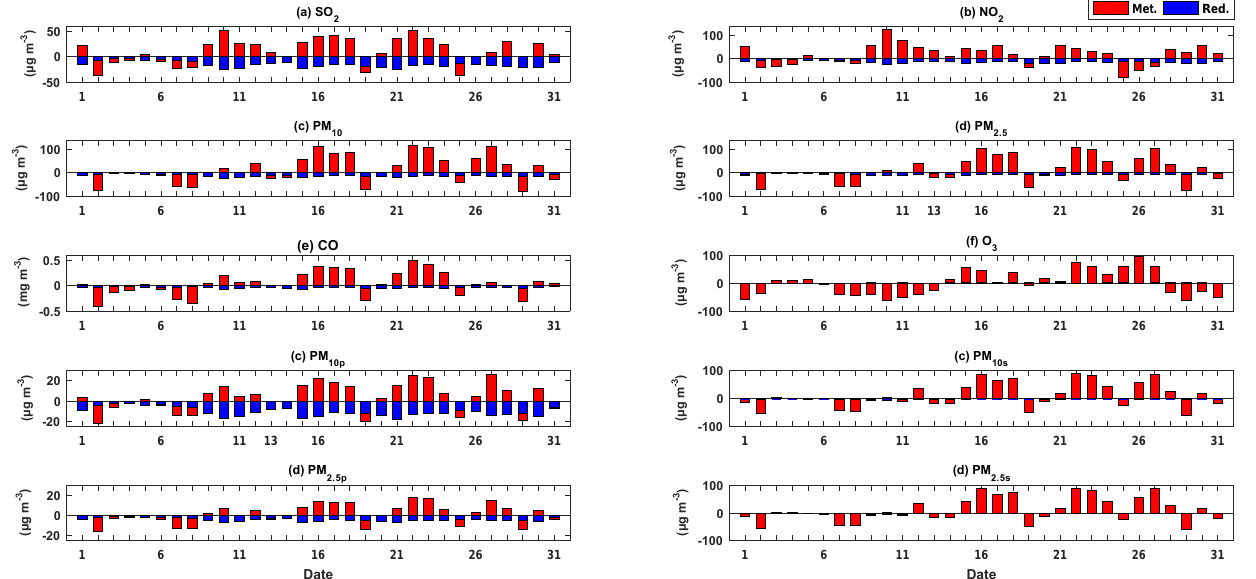
Figure 12. The simulated effect of meteorology and emission reduction on pollutant concentrations in Nanjing during 1–31 August 2014. Met. (Experiment 2–Experiment 3) represents the effect of meteorology while Red. (Experiment 1–Experiment 2) represents the simulated effect of emission